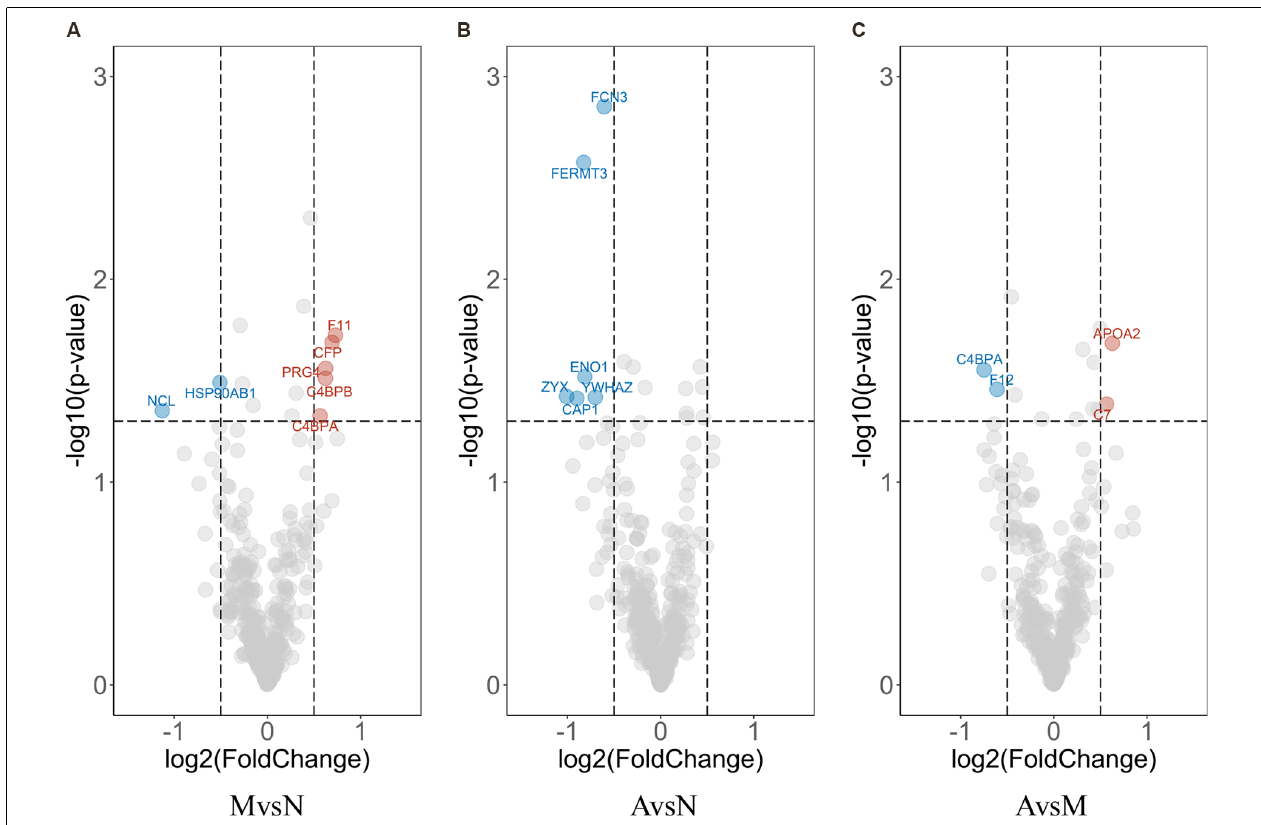
FIGURE 7 | Volcano plot of differential expression analysis. Each dot in the Volcano plot represents a neuron-derived exosomal protein. Difference in expression between two groups and p -values are reported as log2 fold changes and –log10 values, respectively. The cut-off limits are set at p < 0.05 and log2 fold change ≥ 0.5, with red/blue dots signifying the up-/down-regulated DEPs calculated by t -test of MCI vs. normal group (A) ; AD vs. MCI group (B) and AD vs. normal group (C) , respectively. The representative proteins are labeled in the